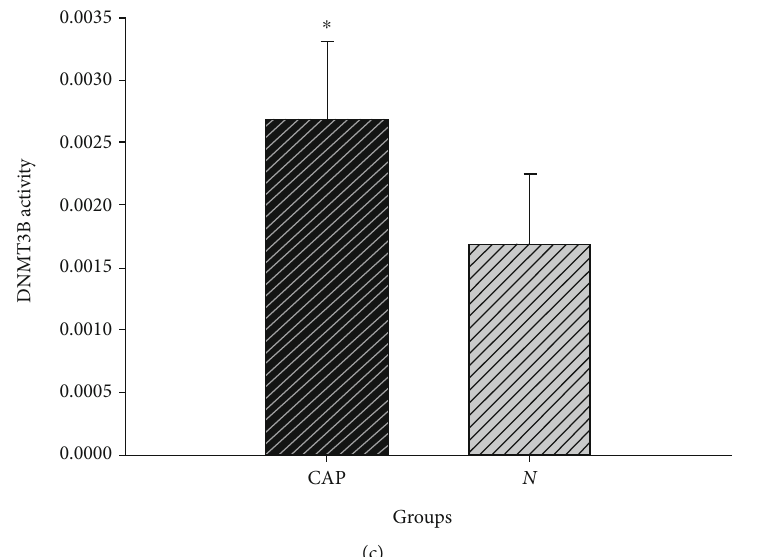
Figure 2: The analysis of DNMTs activity in CAP and NCM tissues. (a – c) showed the total DNMTs, DNMT1, and DNMT3B activities, respectively. ( ∗ P < 0 : 05